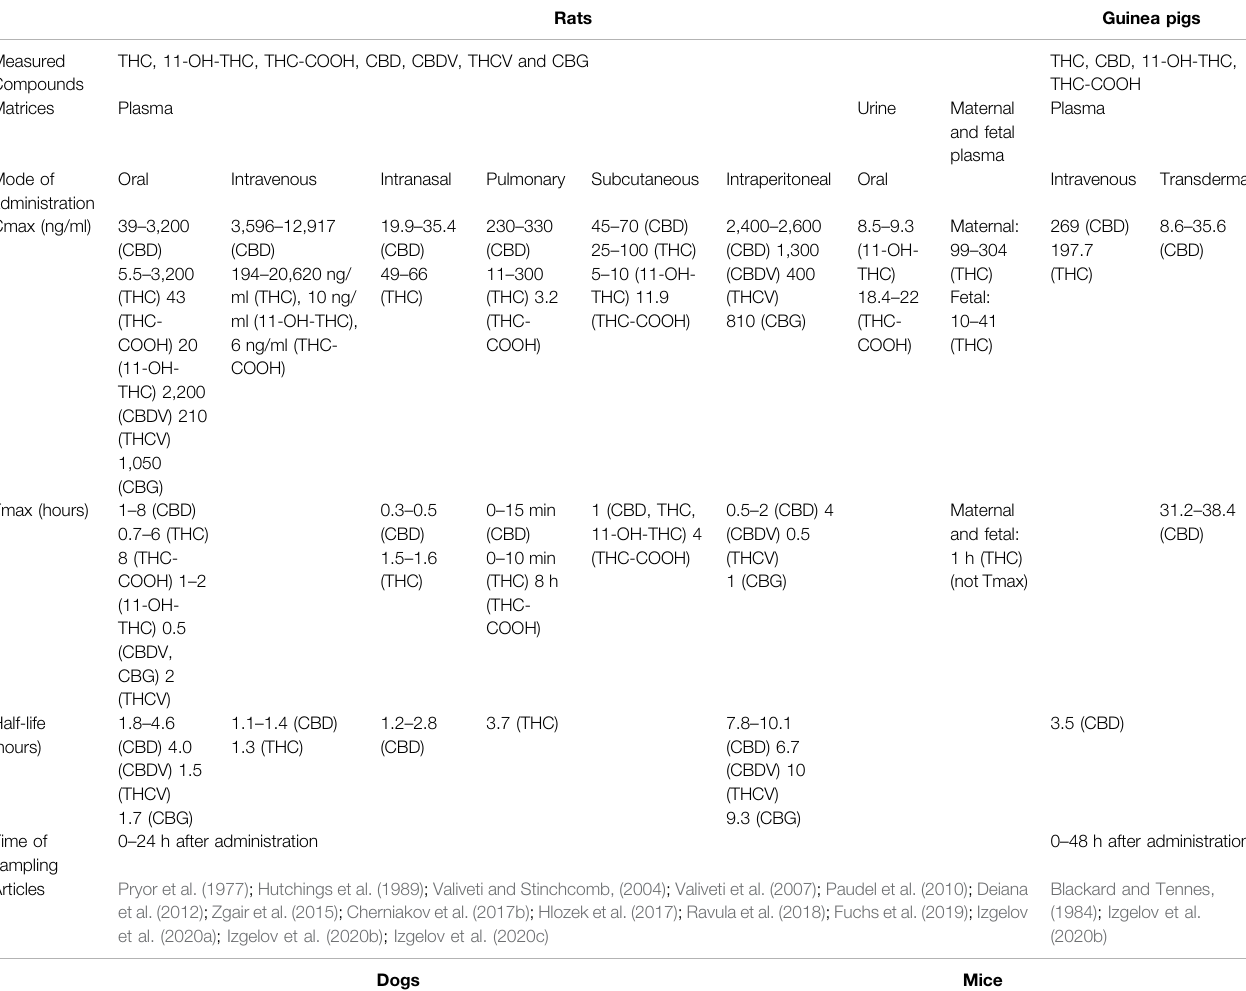
TABLE 3 | Pharmacokinetics of cannabinoids in animal models